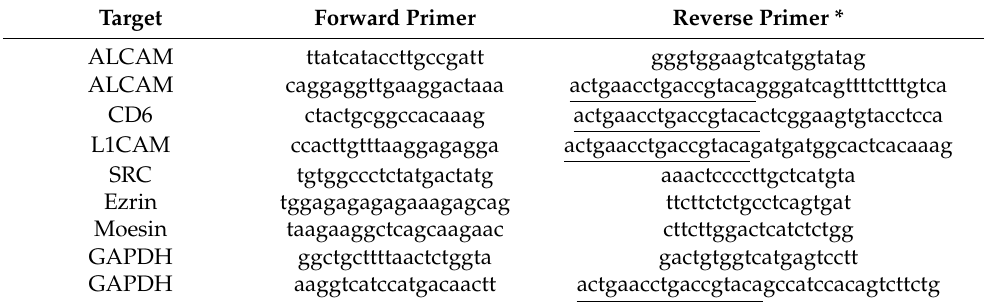
Table 2. Primers used in the